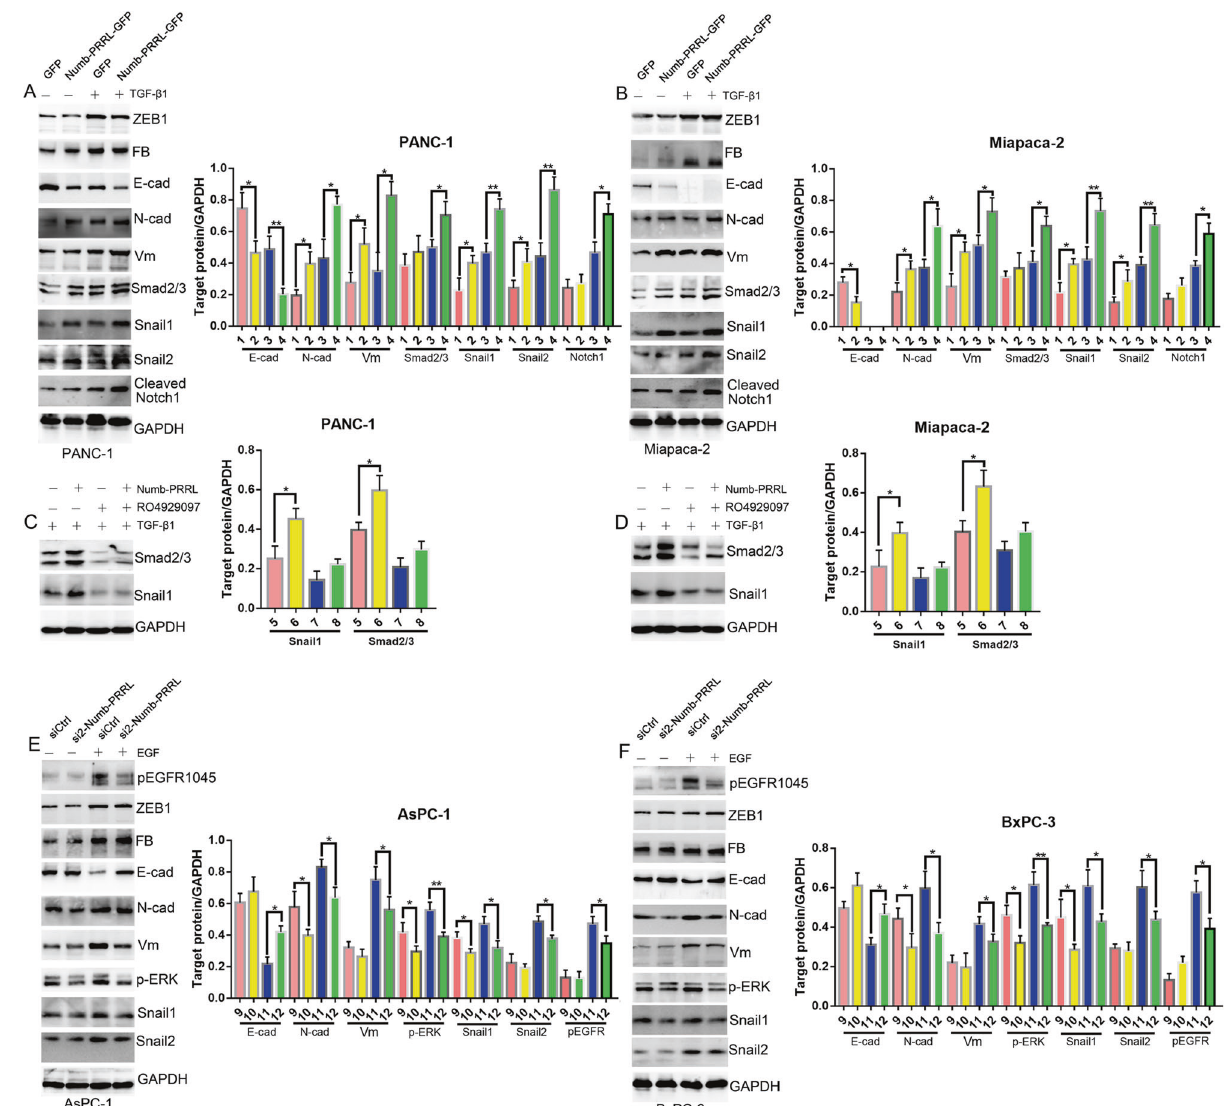
Fig. 5 Numb-PRRL stimulating TGF- β 1-induced Smad2/3-Snail and EGF-induced EGFR-ERK/MAPK signaling in vitro. A , B The EMT biomarkers, ZEB-1, Smad2/3, Snail1, Snail2, and cleaved-Notch1 expression in Numb-PRRL-GFP and GFP transfected PANC-1 ( A ) and Miapaca-2 ( B ) cells with or without TGF- β 1 treatment. C , D The protein expression of Snail1 and Smad2/3 in Numb-PRRL-GFP and GFP transfected PANC-1 ( C ) and Miapaca-2 ( D ) cells with or without TGF- β 1 and RO4929097 treatment. E , F The EMT biomarkers, p-EGFR1045, ZEB-1, p-ERK, Snail1, and Snail2 expression in si2-Numb-PRRL and siCtrl transfected AsPC-1 ( C ) and BxPC-3 ( D ) cells. 1. GFP group; 2. Numb-PRRL-GFP group; 3. GFP group plus TGF- β 1; 4. Numb-PRRL-GFP group plus TGF- β 1. 5. GFP group plus TGF- β 1; 6. Numb-PRRL-GFP group plus TGF- β 1; 7. GFP group plus TGF- β 1 and RO4929097; 8. Numb-PRRL-GFP group plus TGF- β 1 and R04929097, 9. siCtrl group; 10. si2-Numb-PRRL group; 11. siCtrl group plus EGF; 12. si2-Numb-PRRL group plus EGF group. Bars indicate ±S.E. * P < 0.05; ** P < 0.01 compared with